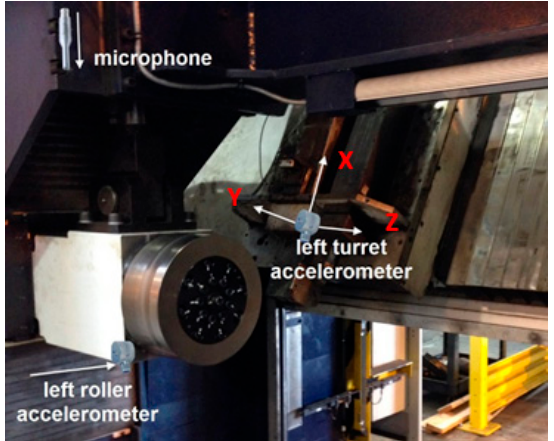
Figure 2. Sensor location during the cutting tests and frequency response function (FRF) determination. The left turret accelerometer was integrated into the hybrid edge–cloud-based smart system.